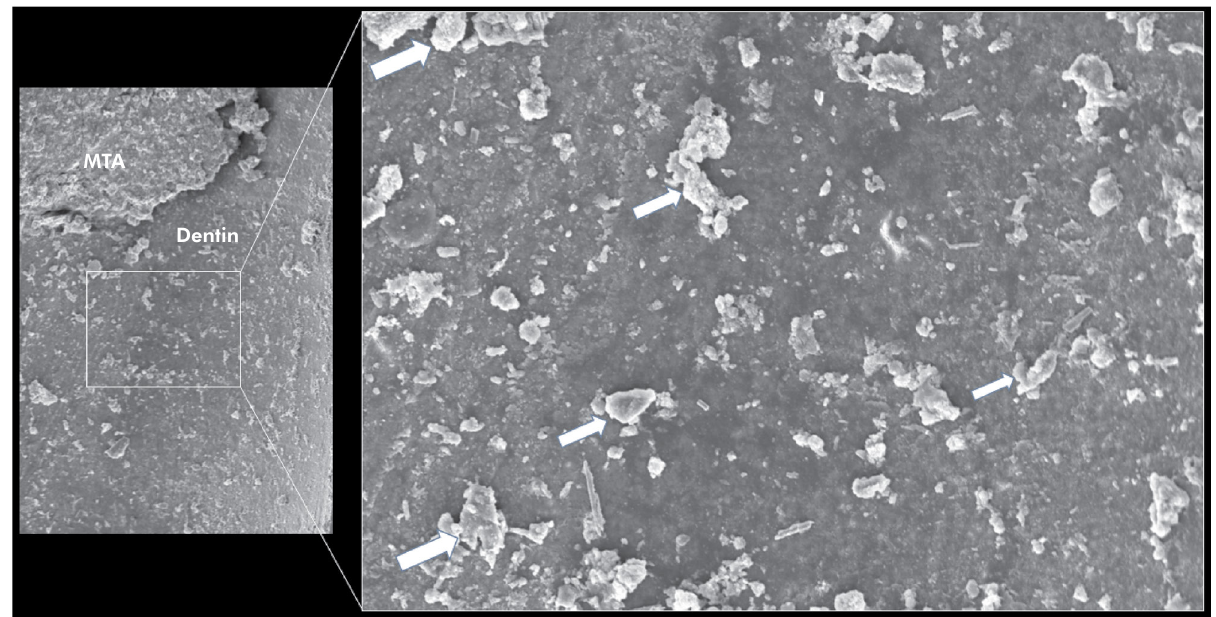
Figure 2. SEM micrographs obtained after the dehydration protocol showing the presence of MTA particles on the dentin surface of the root canal